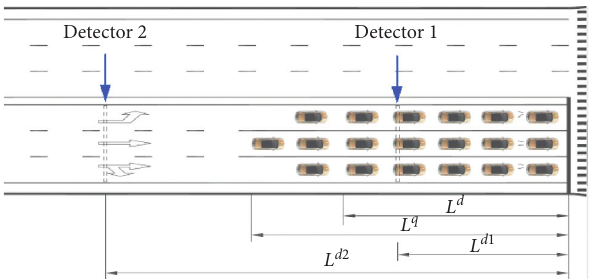
Figure 2: Schematic of detector